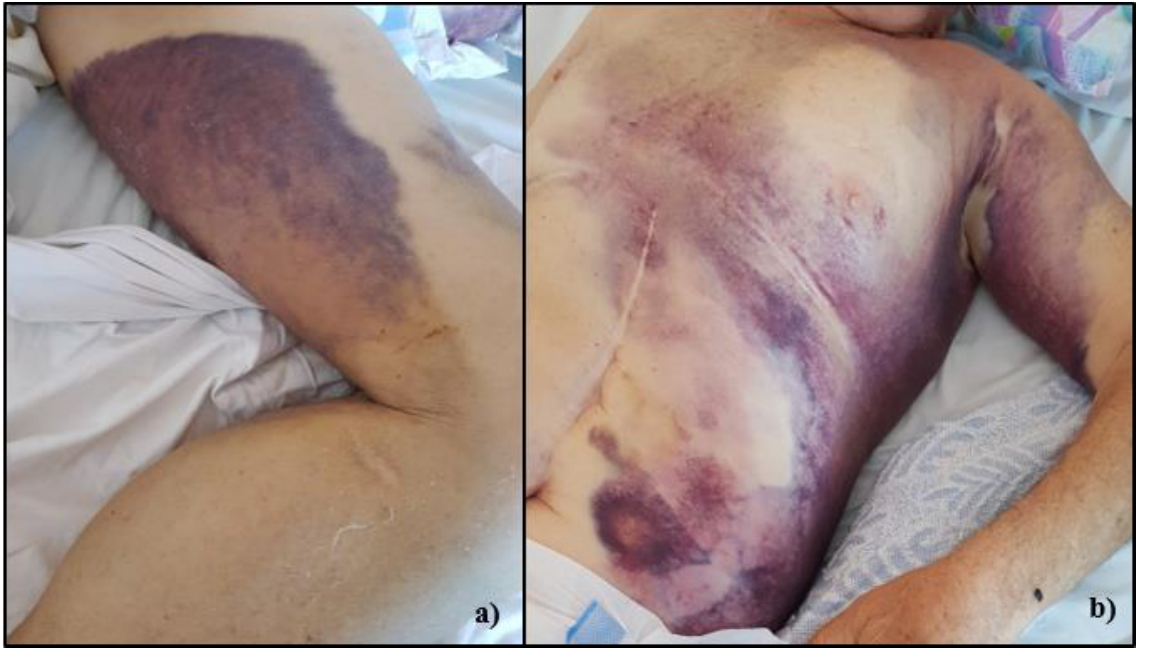
Figure 2. ( a ) left popliteal hematoma with suffusions in the thigh and deep vein thrombosis of the left calf; ( b ) massive left sub-pectoral hematoma.